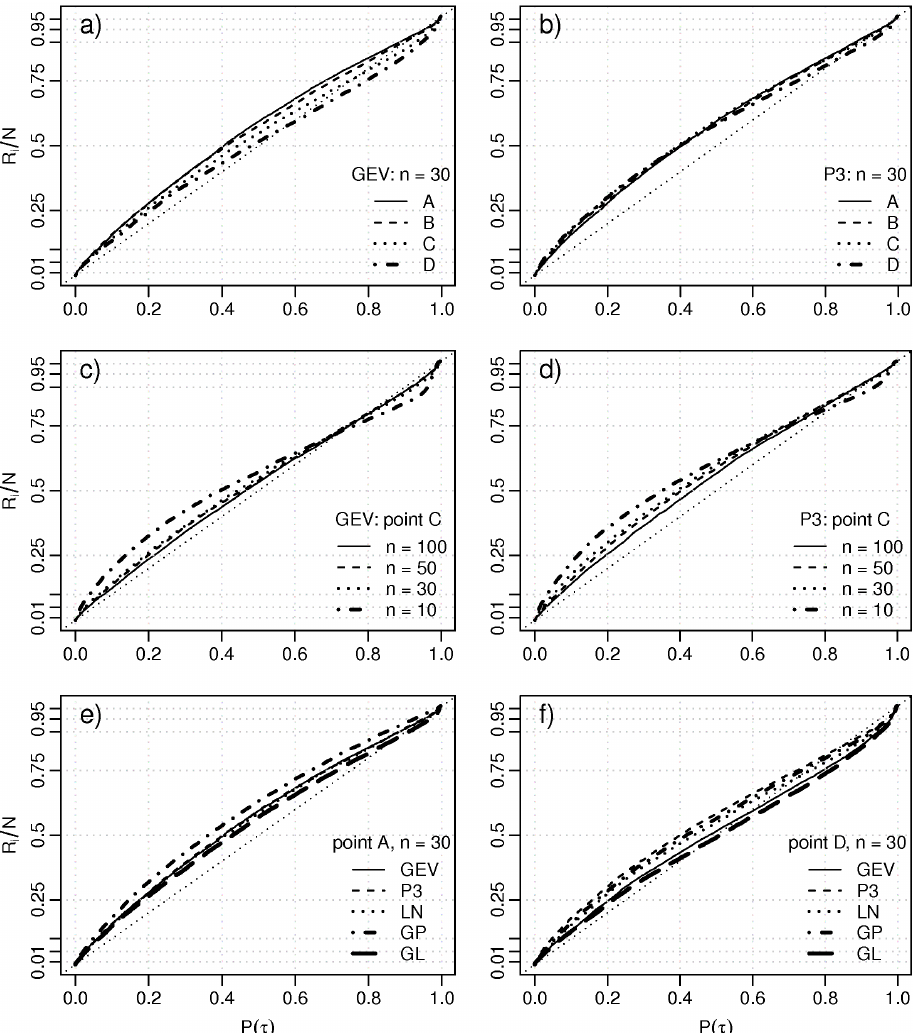
Fig. 5. Probability plot representation of P(τ) for different situations if the BCa distribution is used (Eq. 18). The same cases (a – f) of Fig. 2 are considered